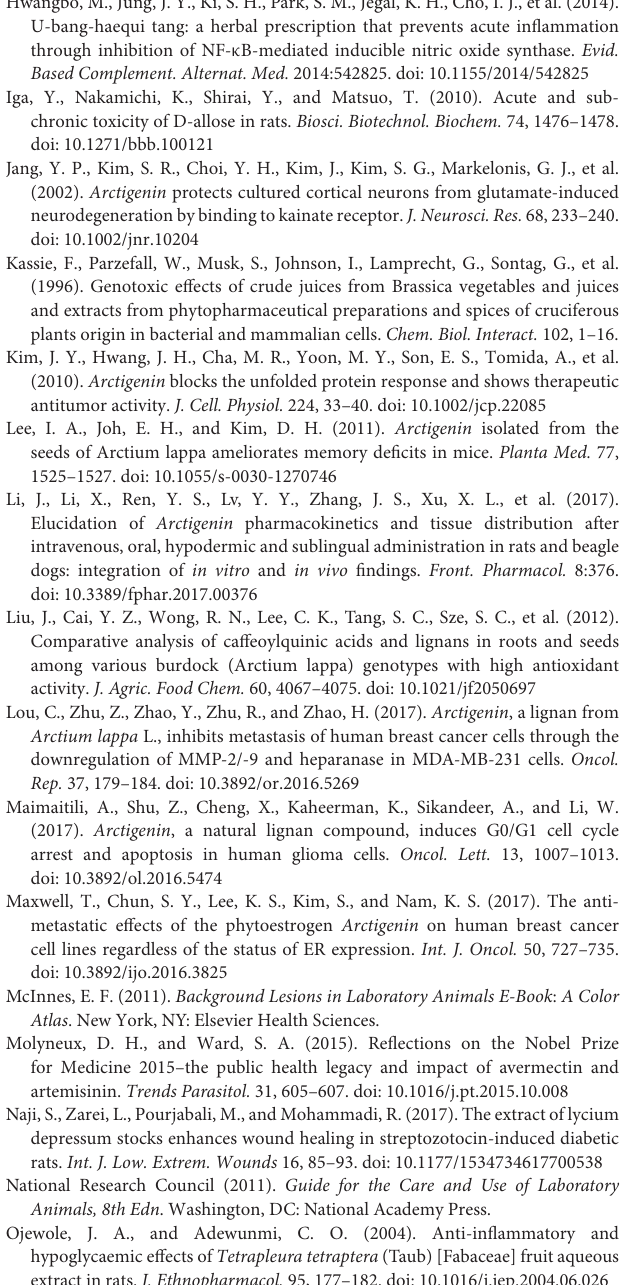
samples (with added Arctigenin and IS) spiked with AG (C) and IS (D) (MRM model). Arctigenin treated rats’ plasma samples (with added IS) spiked with AG (E) and IS (F) (MRM model). Figure S3 | Viscera weights, viscera /body weights, and viscera /brain weights of rats treated with Arctigenin at sub-chronic toxicity levels. (A) Viscera weight of males. (B) Viscera weight of females. (C) Viscera/Body weight of males. (D) Viscera/Body weight of females. (E) Viscera/Brain weight of males. (F) Viscera/Brain weight of females ( n = 10 or 5 per treatment group; results are presented as the mean + SD).